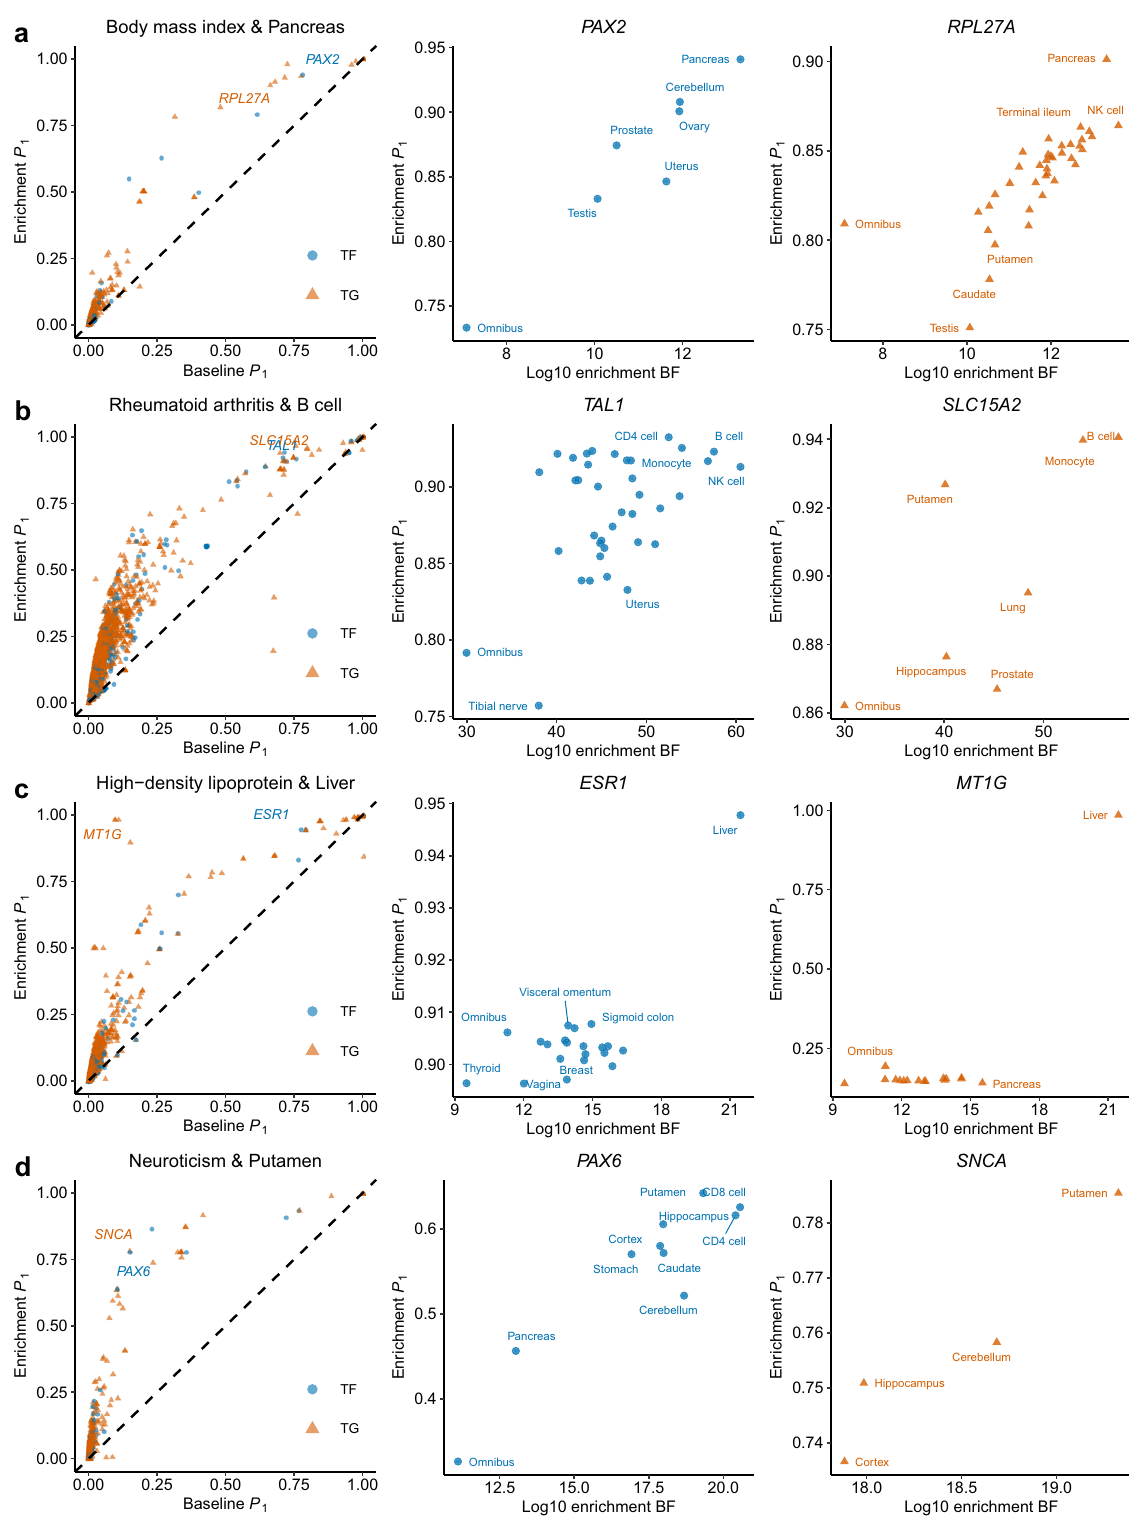
Fig. 6 RSS-NET gene prioritization results of select trait-network pairs. Shown are four trait-network pairs: a body mass index and pancreas; b rheumatoid arthritis and B cell; c high-density lipoprotein cholesterol and liver; d neuroticism and putamen. In the fi rst column of each panel, each point represents a member gene of a given network (blue circle: TF; orange triangle: TG). Dashed lines have slope 1 and intercept 0. In the second and third columns, each point represents a cell type- or tissue-speci fi c network to which a select gene belongs. Numerical values of P 1 and BF are available online (Data availability) and are provided as a Source Data fi